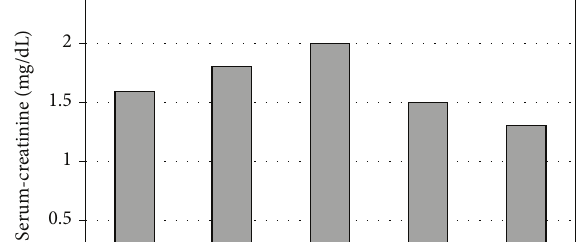
Table 2: Donor characteristics.